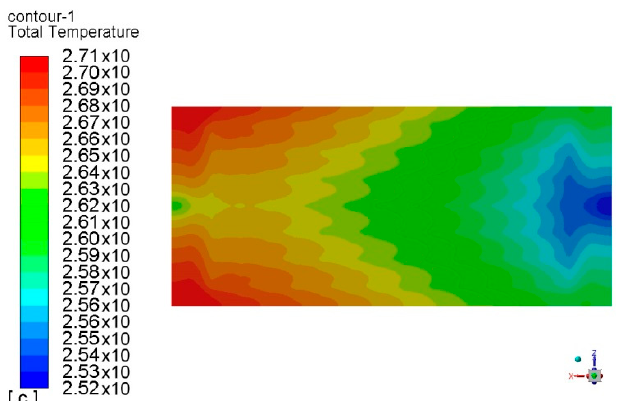
Figure 14. Surface temperature distribution of the cooling plate.